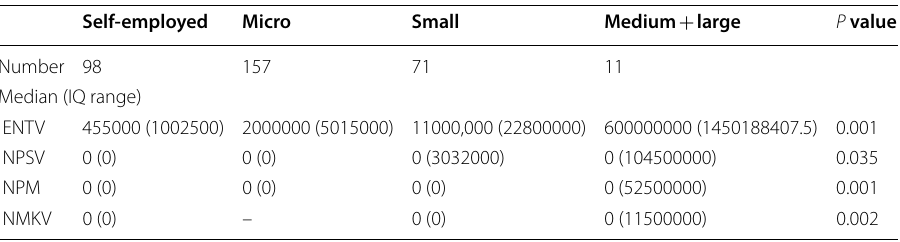
Table 9 Differences between medium-to-large enterprises and micro-to-small, enterprises in the value of innovations carried